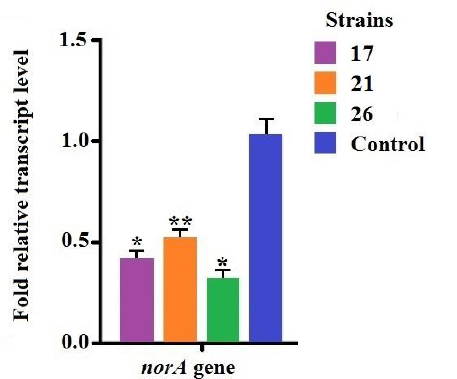
Fig 1. The norA transcription. The expression of norA decrease more than two fold in ciprofloxacin-resistant strains in the presence of thyme extracts (n = 3, *= P  0.01, **= P  0.05). Resistant S. aureus strain in the absence of thyme extract used as negative control.